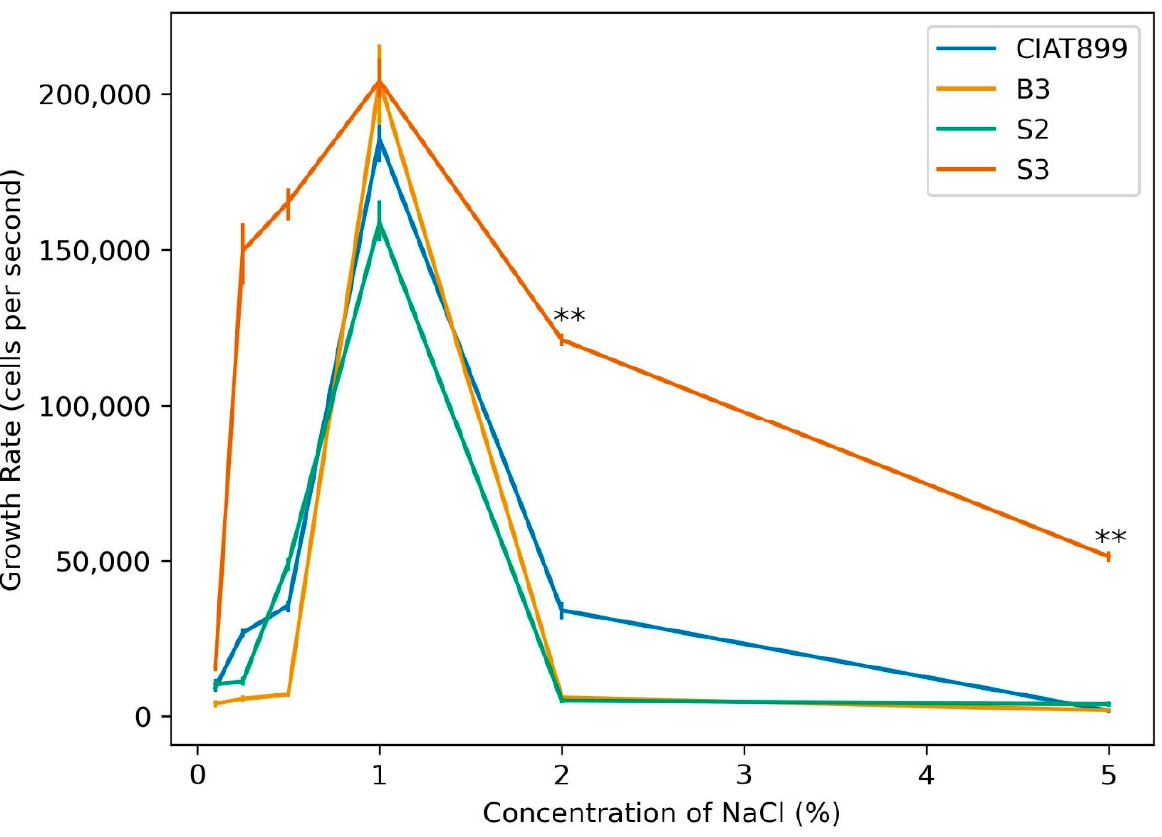
Figure 1. Growth response of rhizobia isolates B3, S2, and S3 in media with different NaCl concen- trations in comparison to the commercial strain CIAT899 (one-way ANOVA; ** indicates p ≤